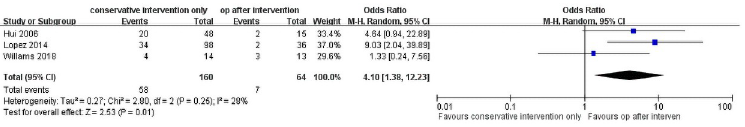
Fig 3. Recurrence rate of conservative approaches only versus surgical approach after initial conservative approaches.